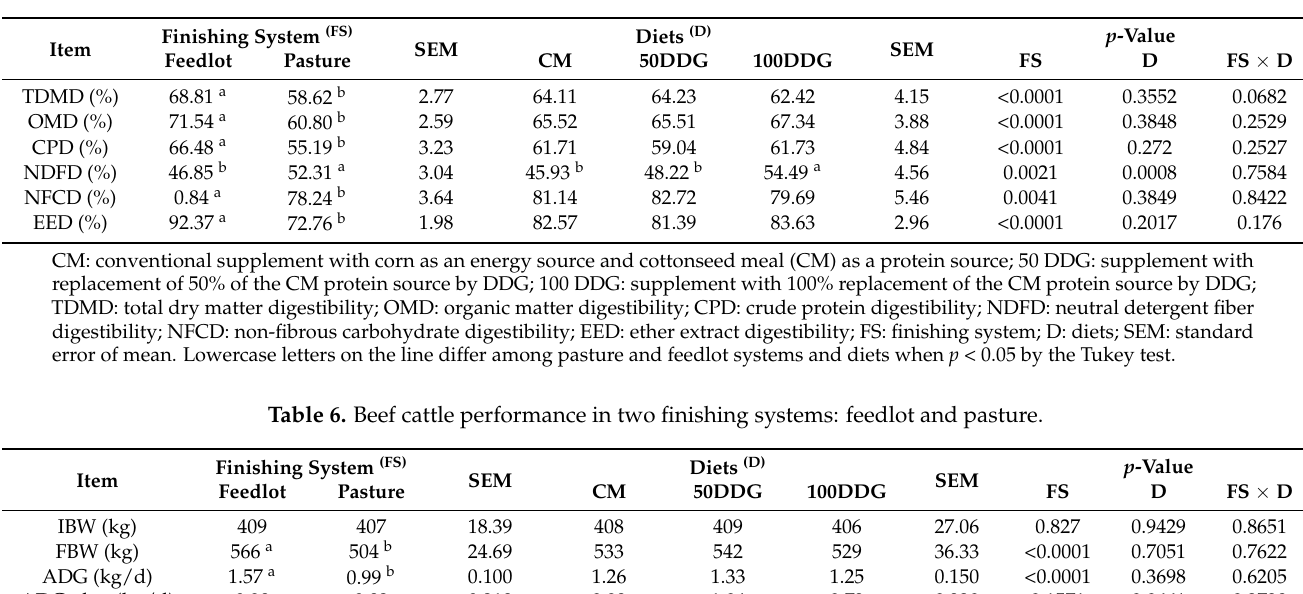
Table 5. Apparent digestibility of nutrients in cattle at pasture and feedlot finishing systems.